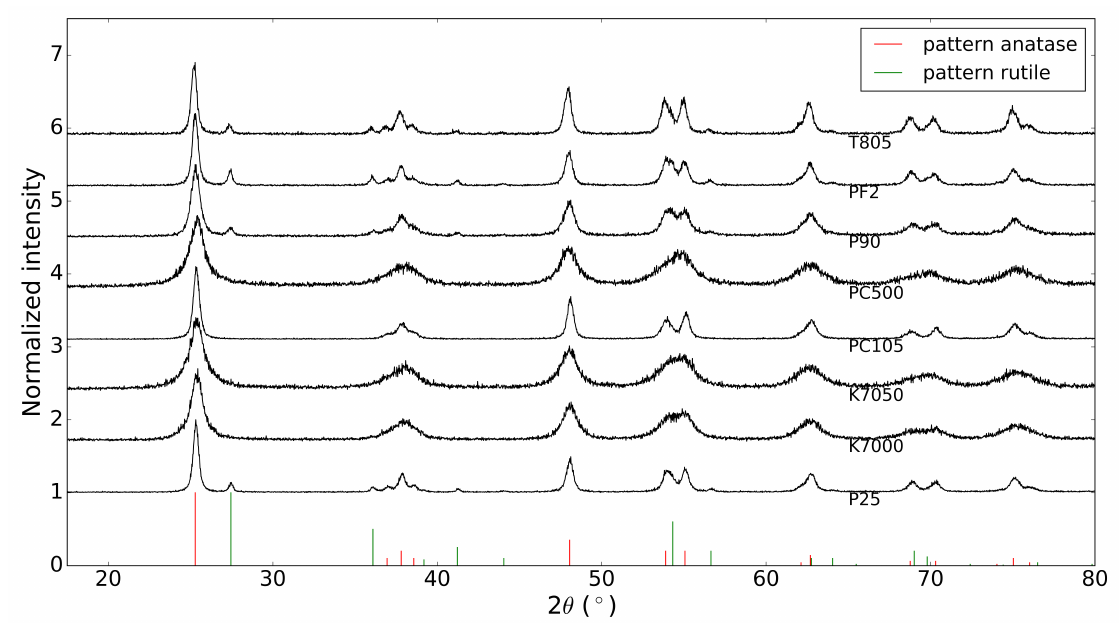
Figure 1. X-ray diffraction patterns of commercial TiO 2 powders (anatase PDF number: 00-021-1272, rutile PDF number: 00-021-1276 [13]).